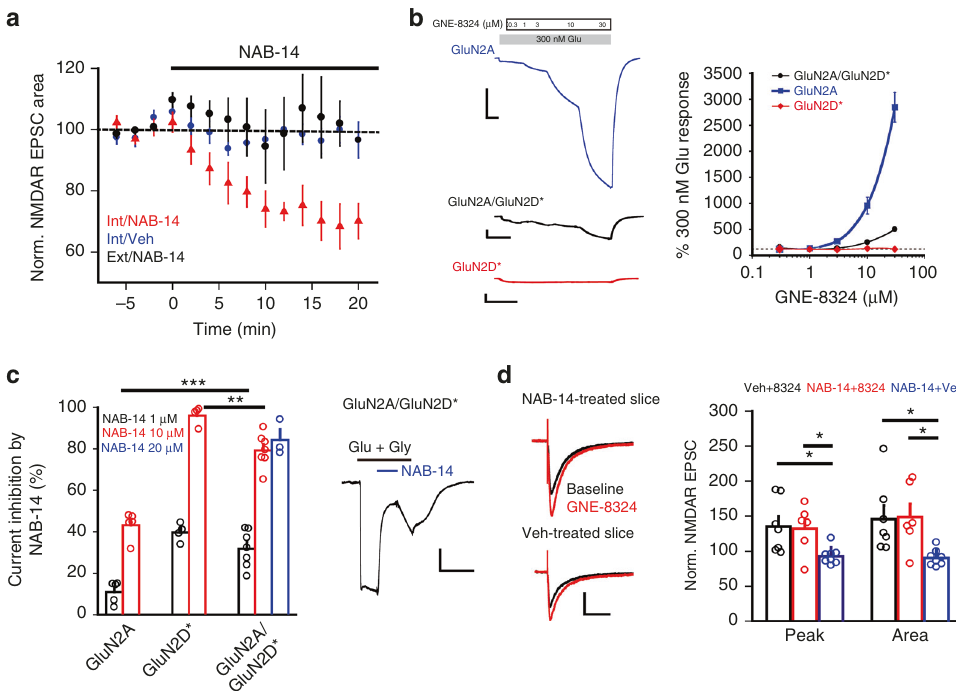
Fig. 6 GluN2C/D-containing NMDARs contribute to NMDAR EPSCs but not GNE-8324 potentiation in inhibitory neurons. a NAB-14 reduces NMDAR EPSC areas in inhibitory but not excitatory neurons. b Sensitivity to GNE-8324. Left: Current trace examples of GNE-8324 dose – response recordings from oocytes expressing either diheteromeric GluN1/GluN2A or GluN1/GluN2D* NMDARs, or triheteromeric GluN1/GluN2A/GluN2D* NMDARs. Scale bars, 200 nA/50 s (top), 20 nA/50 s (middle), and 10 nA/50 s (bottom). Right: GNE-8324 dose – response curves for GluN1/GluN2A, GluN1/GluN2D*, or GluN1/GluN2A/GluN2D* NMDARs. N = 5 – 7 oocytes/concentration. c Sensitivity to NAB-14. Effect of 1 and 10 µ M NAB-14 on diheteromeric GluN1/ GluN2A NMDARs, diheteromeric GluN1/GluN2D* NMDARs, and triheteromeric GluN1/GluN2A/GluN2D* NMDARs. Later, 20 µ M NAB-14 was also tested. Right: Illustrative current trace showing inhibition of triheteromeric GluN1/GluN2A/GluN2D* NMDAR activity by 20 µ M NAB-14. Scale bars, 20 nA/40s. N = 3 – 7 oocytes/concentration. ** P < 0.01, *** P < 0.001, one-way ANOVA with Tukey's correction. d NAB-14 does not affect the level of GNE- 8324 potentiation on NMDAR EPSCs in inhibitory neurons. Left: Sample traces showing similar potentiation of NMDAR EPSCs by GNE-8324 in NAB-14- treated slice and Veh-treated slice. Scale bars, 50 pA/100 ms. N = 7, 6, 8, for Veh + 8324, NAB-14 + 8324, and NAB-14 + Veh, respectively. * P < 0.05, one-way ANOVA with Dunnett's correction. Right: Population data. Error bars represent